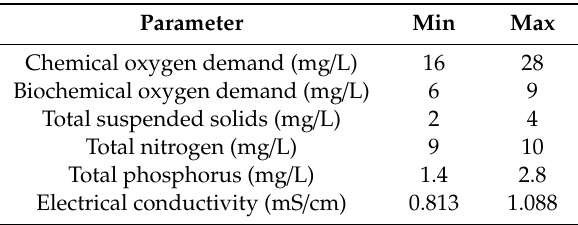
Table 1. Gross parameters of the treated